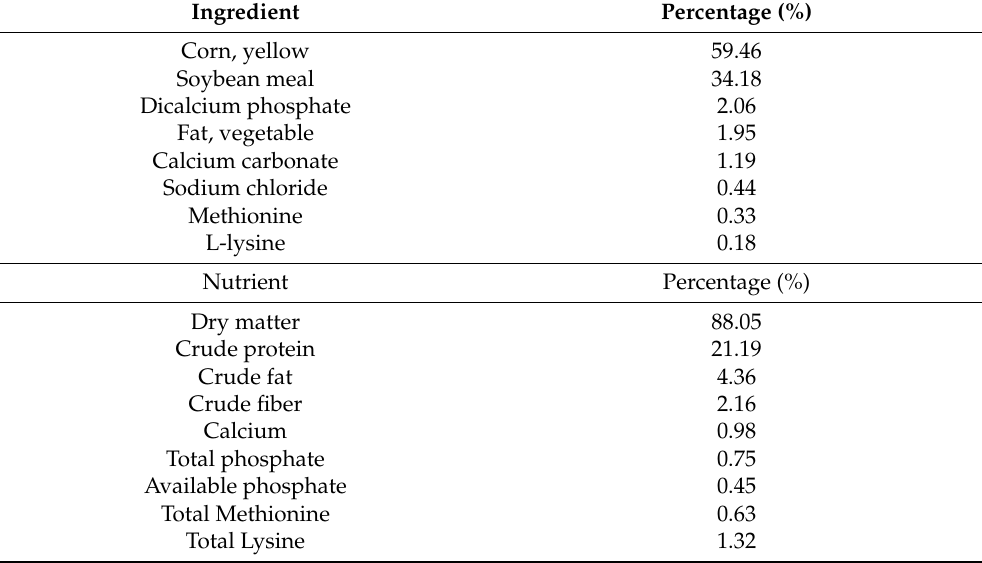
Table 1. Composition of Broiler Starter Grower